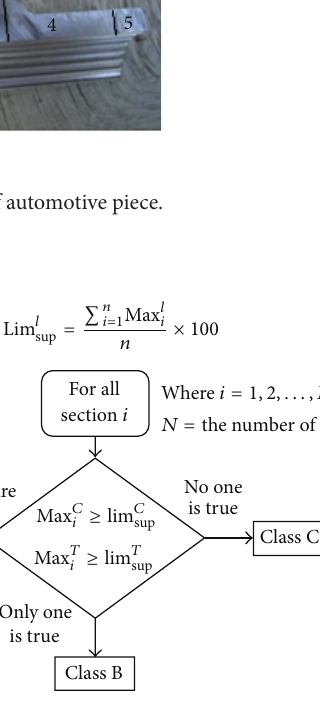
Figure 4: Flowchart for the first phase of the section classifying